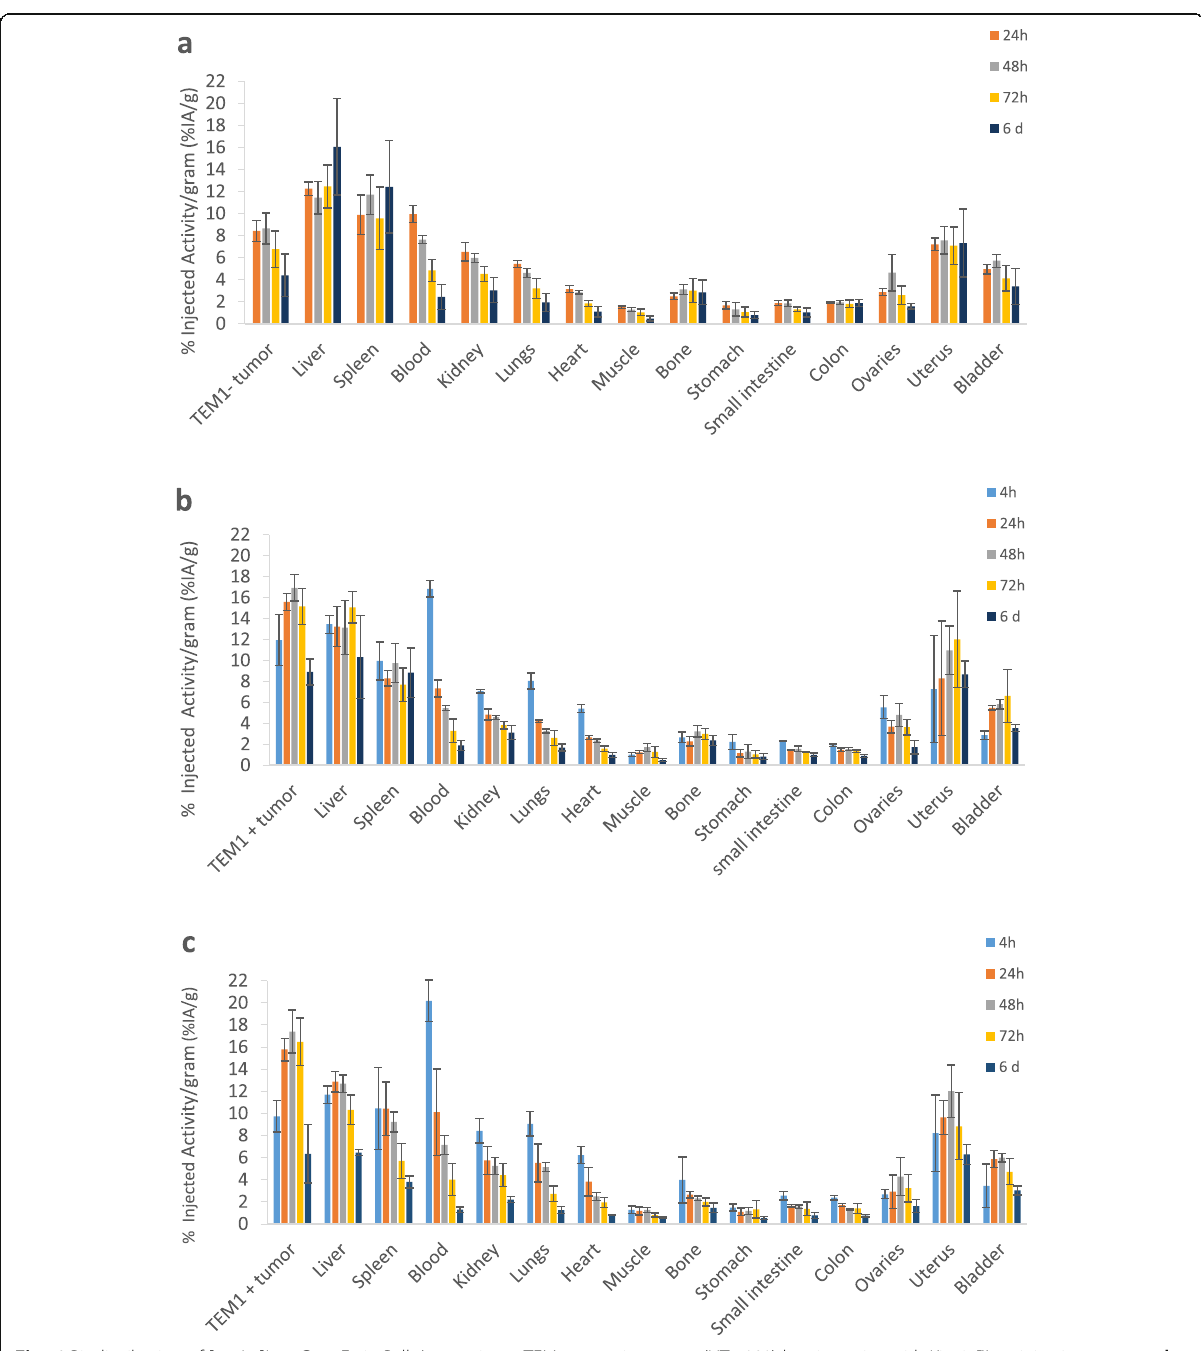
Fig. 6 Biodistribution of [177Lu]Lu-1C1m-Fc in Balb/c nu mice. a TEM-1 negative tumor (HT-1080)-bearing mice with Kiovig ™ preinjection, group 1. b TEM-1 positive tumor (SK-N-AS)-bearing mice with Kiovig ™ preinjection, group1. c TEM-1 positive tumor (SK-N-AS)-bearing mice without Kiovig ™ preinjection, group 2. Data are shown as mean ± SD. There were significant differences between uptake in TEM-1 positive tumors compared with TEM-1 negative tumors ( p = 0.0006 at 24h). There was no difference on the biodistribution with or without Kiovig ™ preinjection (all p > 0.059) Table 2 Liver and tumor uptake regarding the estimated number of DOTA fixed on 1C1m-Fc Estimated number of